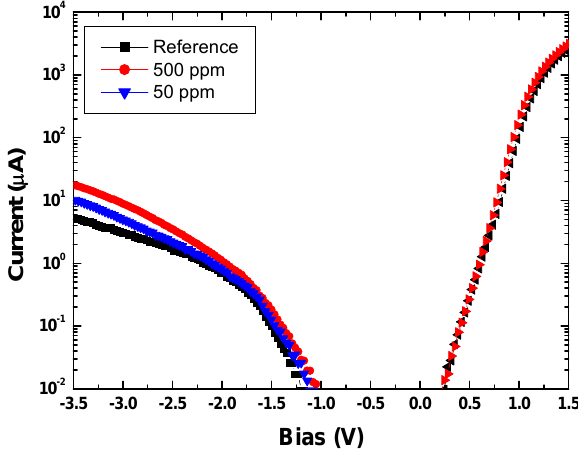
Figure 11. Forward and reverse bias plot of diode current in varying